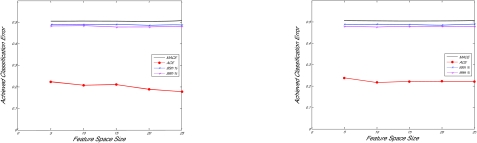
PACE analysis using a SVM-based classifier using the AUC scoring criterion, with a 0.6 MAC threshold. Left Panel: performance without peak selection. Right panel: performance with peak selection.